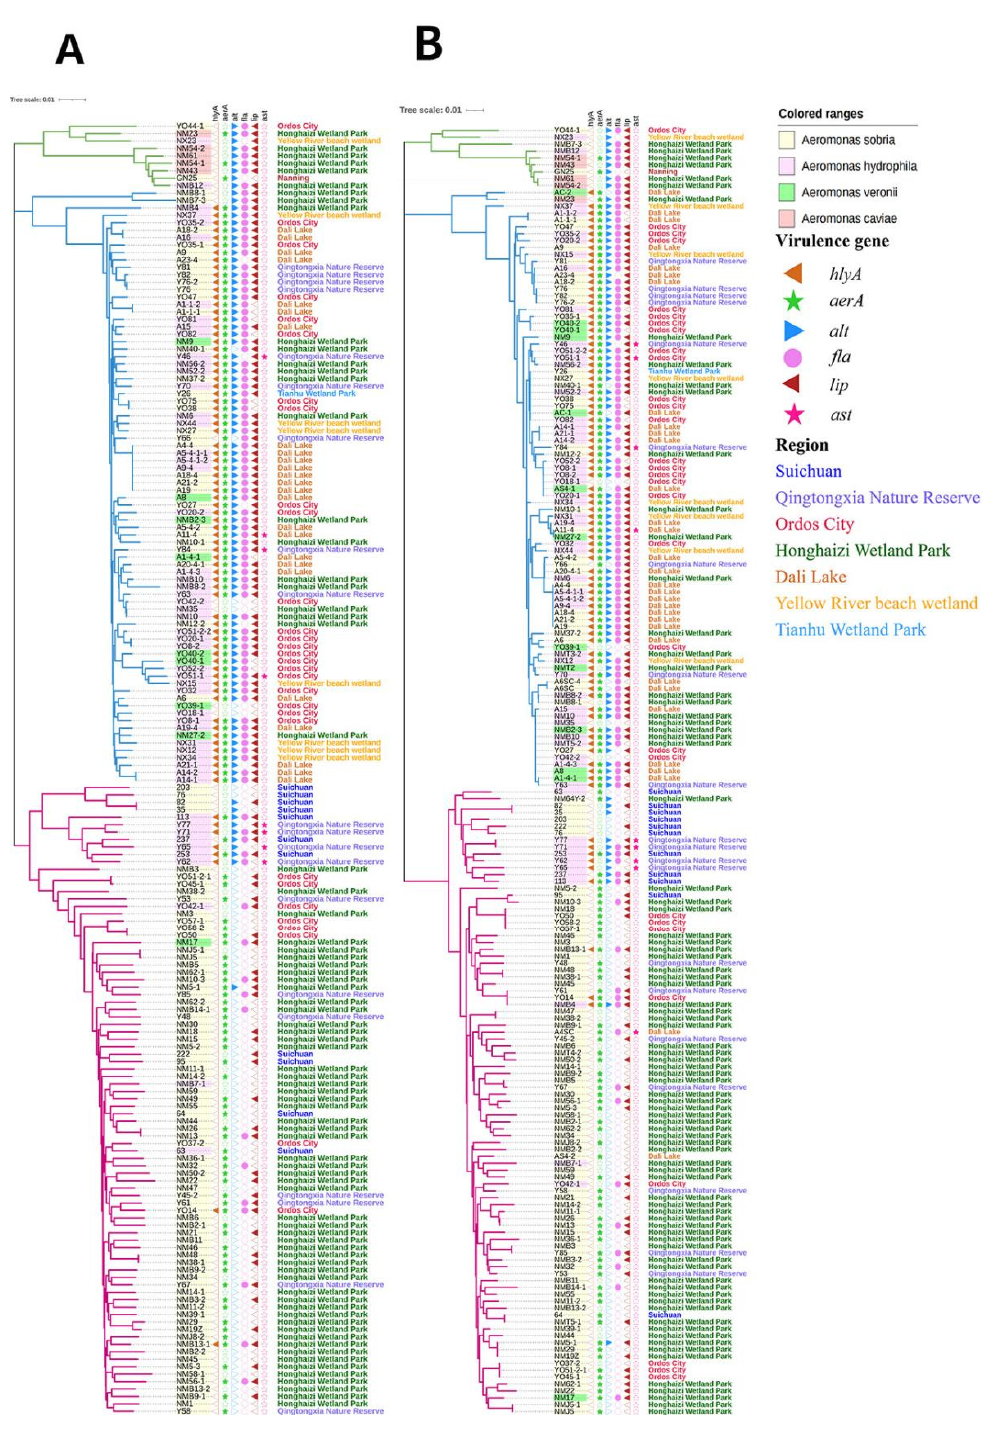
Figure 3. Unrooted phylogenetic trees based on the combined stretch of gyrB - groL - gltA - metG - ppsA - recA ( A ) and PPSA ( B ) gene sequences, showing relationships in the genus Aeromonas from migratory birds in this study. A solid symbol shows that the strain contains virulence-associated genes; a hollow symbol shows that the strain did not contain the virulence-associated gene. Colored rectangles represent the species of Aeromonas . For each strain, the shapes of different colors indicate the presence of the virulence factor genes analyzed in this study. The different color characters represent Aeromonas strains isolated from the seven different regions in China.